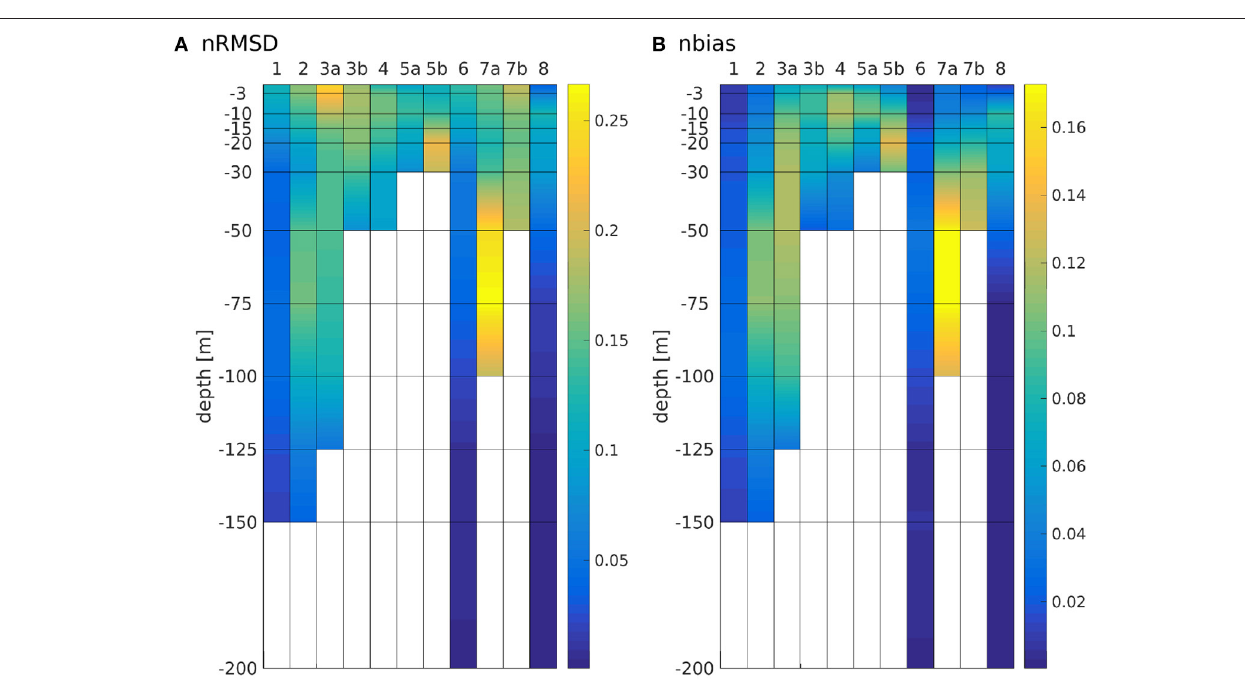
without considering chlorophyll specific attenuation. The ratio noticeably increases in the areas where the absolute reductions of the 1%- and 10%-depths are greatest ( Figures 9A,B ), which is due to the self shadowing of phytoplankton. Capuzzo et al.